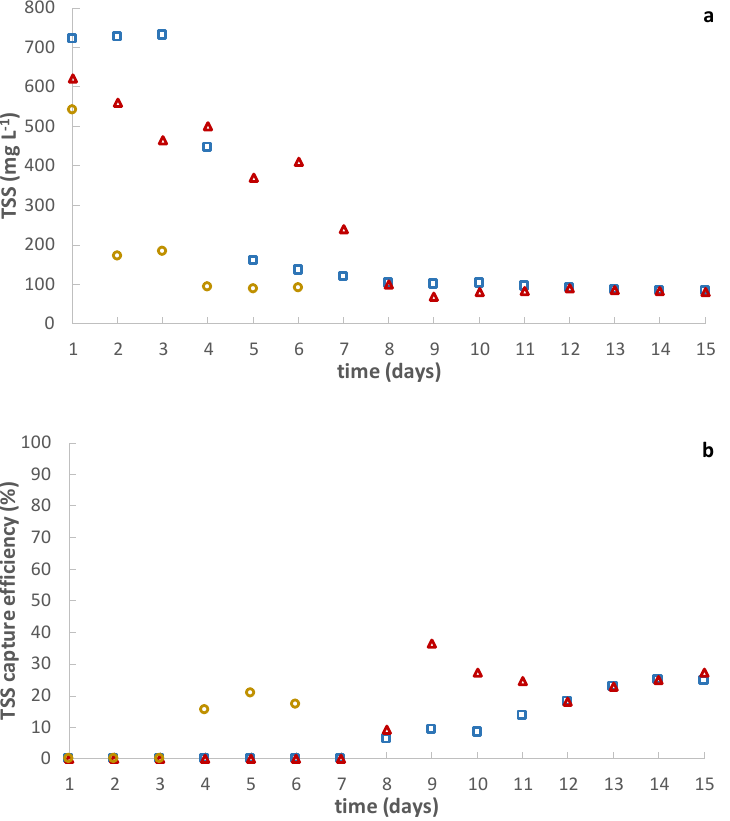
Figure 2. Pilot-plant performance. Evolution of ( a ) transmembrane pressure (TMP) and total sus- Figure 6. Lab-scale DM performance. Effect of influent total suspended solids (TSS) concentration Figure 6. Lab-scale DM performance. Effect of influent total suspended solids (TSS) concentration ( Figure 6. Lab-scale DM performance. Effect of influent total suspended solids (TSS) concentration ( pended solids (TSS) concentration, and ( b ) TSS capture efficiency and permeate TSS concentration. Figure 6. Lab-scale DM performance. Effect of influent total suspended solids (TSS) concentration ( TMP average ; TSS in the membrane tank; TSS capure efficiency; TSS in the permeate. The 1.9 g L − 1 ; 4.7 g L − 1 ; 9.2 g L − 1 ) on: ( a ) TSS in the permeate and ( b ) TSS capture efficiency. Note 1.9 g L − 1 ; 4.7 g L − 1 ; 9.2 g L − 1 ) on: ( a ) TSS in the permeate and ( b ) TSS capture efficiency. Note ( 1.9 g L − 1 ; 4.7 g L − 1 ; 1.9 g L − 1 ; 4.7 g L − 1 ; 9.2 g L − 1 ) on: ( a ) TSS in the permeate and ( b ) TSS capture efficiency. Note continuous lines represent linear fits. that the TSS capture efficiency was calculated based on the original influent used (see Table 1). that the TSS capture efficiency was calculated based on the original influent used (see Table 1). that the TSS capture efficiency was calculated based on the original influent used (see Table 1). Table 5. Average transmembrane pressure (TMP) after the dynamic membrane formation.